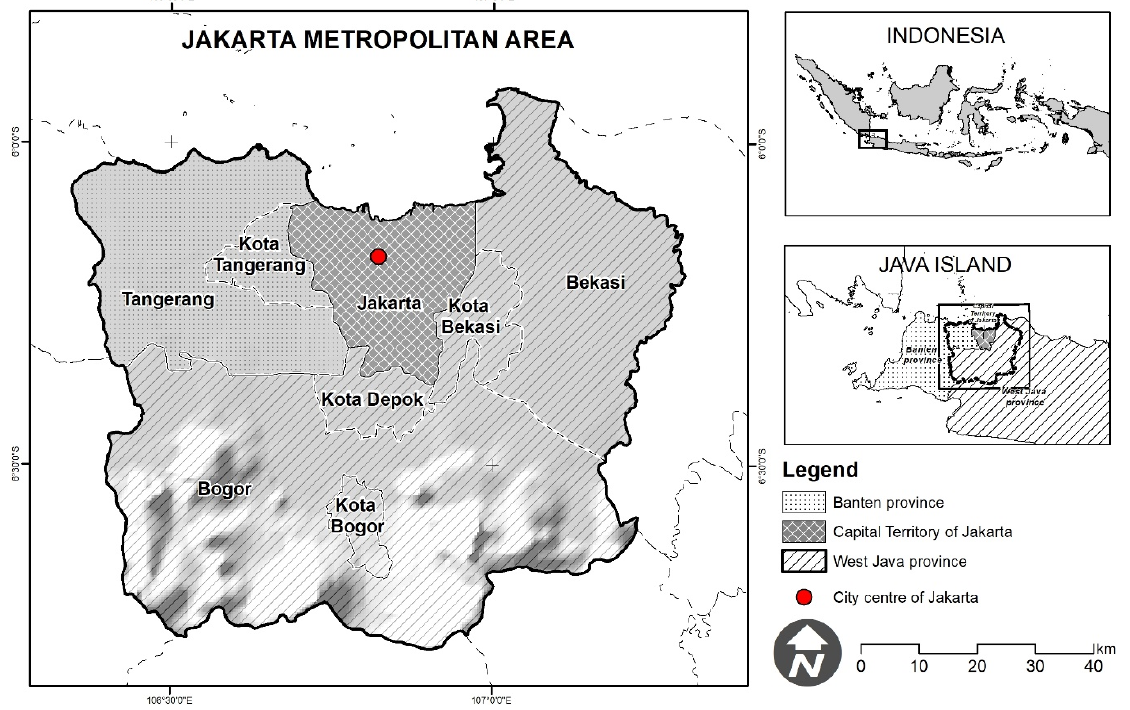
Figure 1. The Jakarta Metropolitan Area in Indonesia.